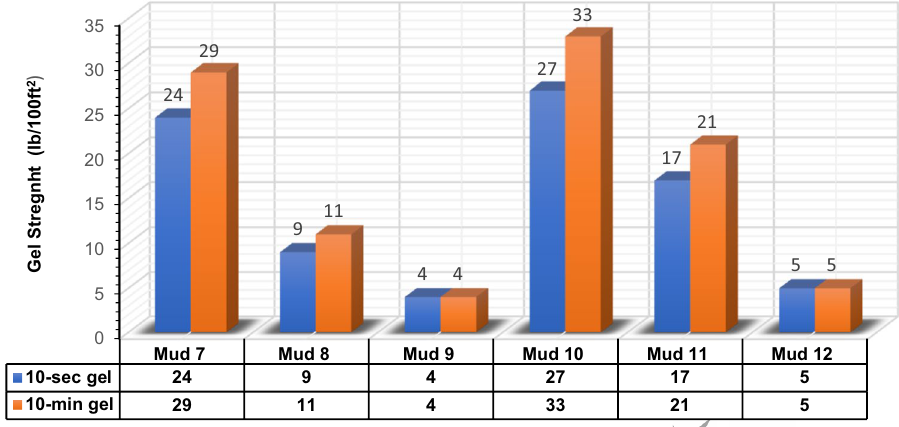
Fig. 11 Comparison of the viscosities of drilling muds containing a salt: a viscosities of mud formulations after static aging at 25 °C; b viscosi- ties of mud formulations after hot rolling at 100 °C; c viscosities of mud formulations after hot rolling at 120 °C Fig. 12 Gel strengths of the drilling